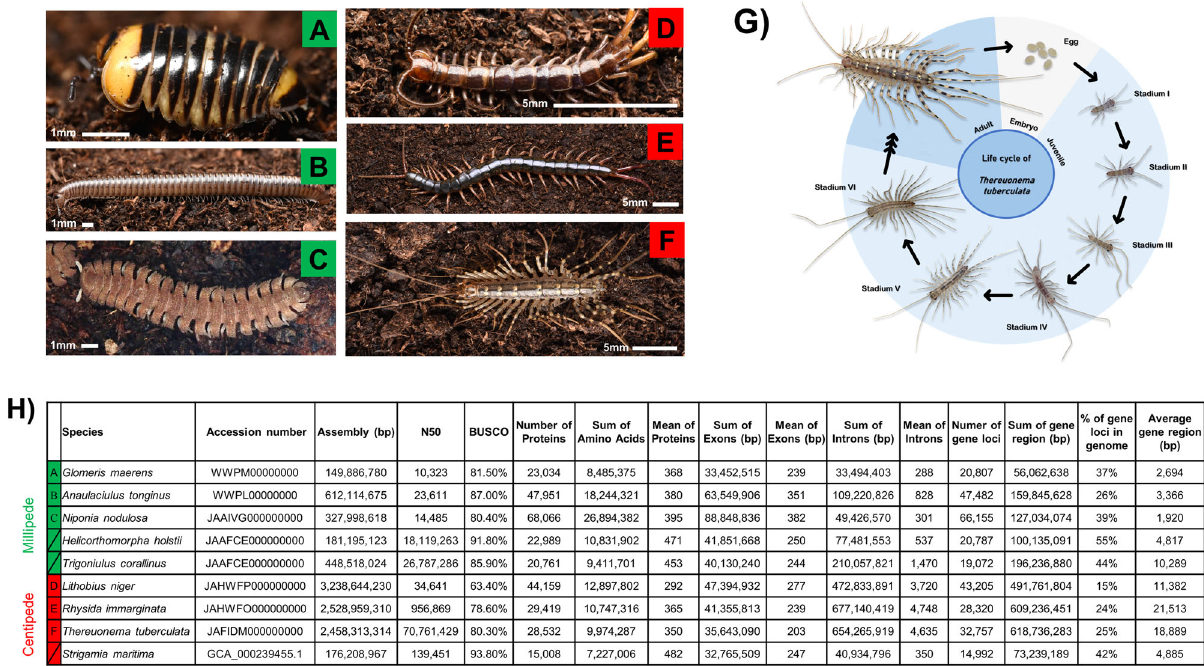
Fig. 1 Myriapods used and sequenced in this study. A Glomeris maerens ; B Anaulaciulus tonginus ; C Niponia nodulosa ; D Lithobius niger ; E Rhysida immarginata ; F Thereuonema tuberculata ; G Life cycle of T. tuberculata . H Genome sequencing information and statistics. The letters labelled in green are millipede species while the letters labelled in red are centipede